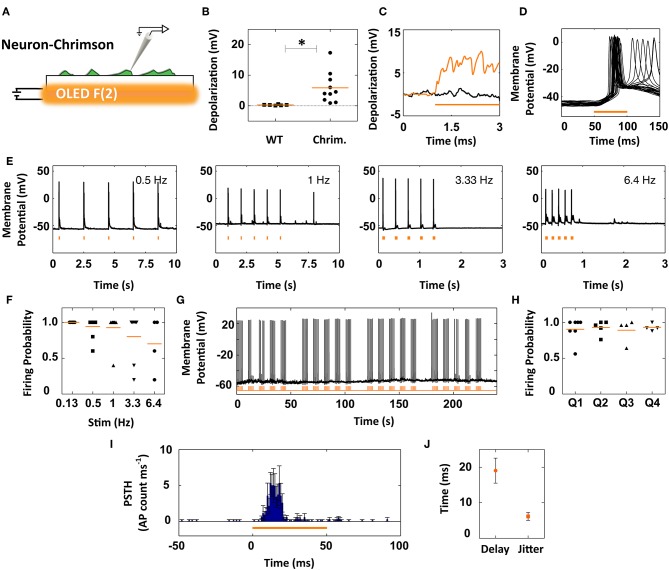
Coupling of orange OLEDs to ChrimsonR-expressing neurons for millisecond control of action potential firing. (A) Primary neurons were transduced with lentiviral vectors encoding ChrimsonR, and responses to orange OLED illumination were recorded by patch-clamp. (B) Subthreshold responses to 50 ms illumination in ChrimsonR-expressing cells. Control mock-transduced neurons (WT) showed no responses to light (p < 0.05, Mann-Whitney U-test). (C) Representative subthreshold responses to prolonged (2 s) illumination of ChrimsonR-expressing cells (orange trace) and mock-infected neurons (black trace). (D) Overlay of membrane responses of a single ChrimsonR-expressing neuron to 25 repetitions of 50 ms pulses, successfully triggering action potential firing. (E) Representative traces of neurons successfully firing action potentials during five consecutive 50 ms light stimuli at various inter-stimulus repetition rates. (F) Firing probability vs. stimulus frequency (0.13–6.4 Hz), calculated over first five stimuli per cell (symbols); orange lines represent the group means. (G) Representative spiking activity in response to five trains (each composed of five 1 Hz-stimuli) administered at 0.1 Hz. (H) Firing probability over multiple repetitions (25–100) following the stimulation protocol shown in (G) for individual cells (symbols) and group means (lines). (I) Peristimulus time histogram for the time window 50-ms-before/50-ms-after the stimulus (1 ms bins). (J) Quantification of the delay and jitter of action potential firing based on the first spike per stimulus calculated across all recorded neurons.